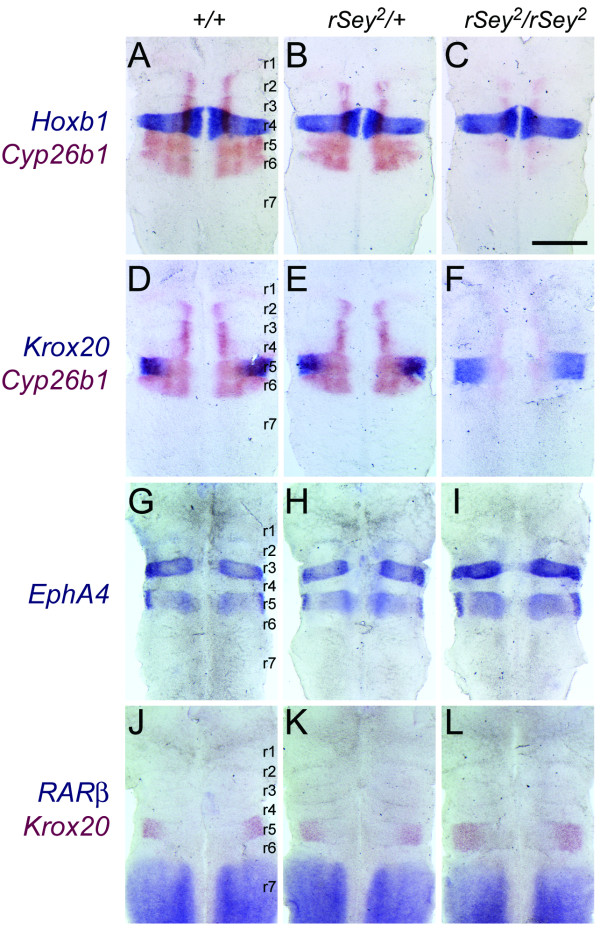
The rhombomere 5 region is broadened in the rSey2/rSey2 hindbrain. (A-F) The expression sites of Hoxb1 and Krox20 (blue) were compared with that of Cyp26b1 (red) in WT (A, D), rSey2/+ (B, E) and rSey2/rSey2 (C, F) hindbrains. (A-C) Hoxb1 expression (as a marker of r4) is unchanged in the rSey2/rSey2 hindbrain (C). (D-F) Krox20 expression (as a marker of r5; cannot detect in r3 at E11.5) overlaps with Cyp26b1 expression in the dorsolateral domain of the WT and rSey2/+ hindbrain (D and E). The r5 region is slightly broadened in the rSey2/rSey2 hindbrain along the anterior-posterior axis (F). (G-I) EphA4 expressed in both r3 and r5 of the E11.5 hindbrain. EphA4 expression domains (blue) are broadened only within the r5 region of the rSey2/rSey2 hindbrain (I) as compared to the WT (G). (J-L) The expression site of RARβ (blue) was compared with that of Krox20 (red) in WT (J), rSey2/+ (K) and rSey2/rSey2 (L) hindbrains. Krox20 expression is posteriorly expanded in the rSey2/rSey2 hindbrain (L), although the anterior border of RARβ expression (anterior edge of r7 in L) is not altered. Scale bar: 500 μm.